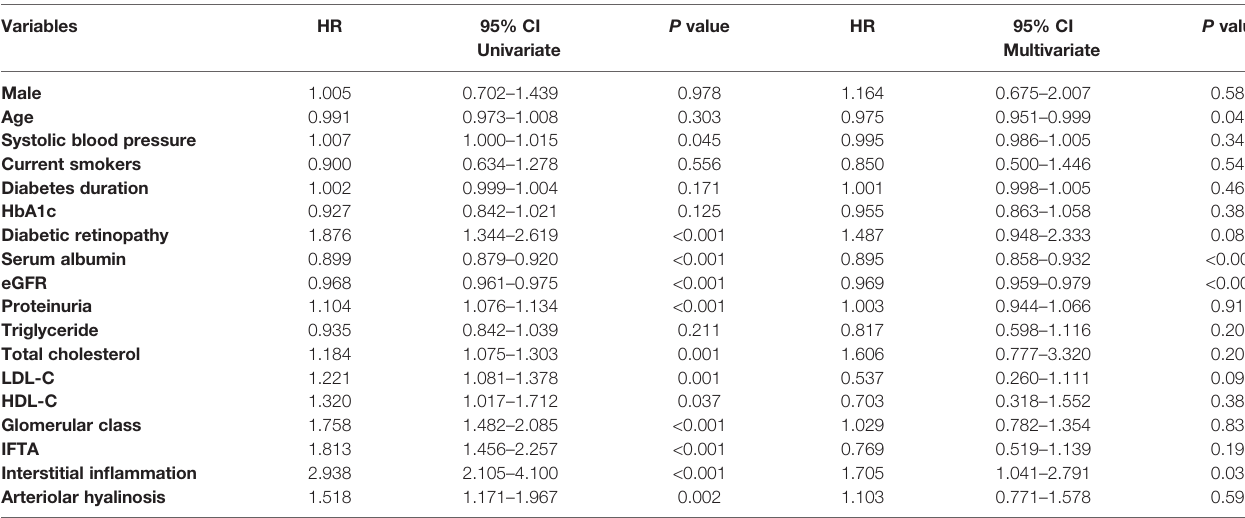
TABLE 2 | Risk factors of